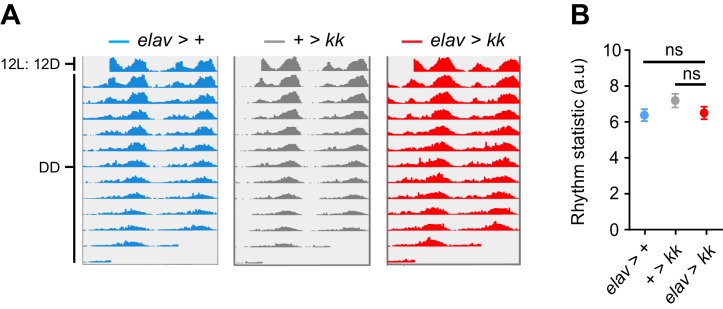
Nca knockdown does not alter circadian rhythmicity.(A) Actograms showing representative individual patterns of locomotor activity in one day of 12L: 12D conditions followed by 11 days of free-running activity in constant dark (DD) conditions. (B) Mean locomotor rhythm strength in NcaKD adult males and controls. Robust circadian patterns of locomotor activity were still observed following in adult males expressing Nca RNAi (kk) under elav-Gal4 relative to controls. Error bars represent standard error of the mean. n = 14–15.